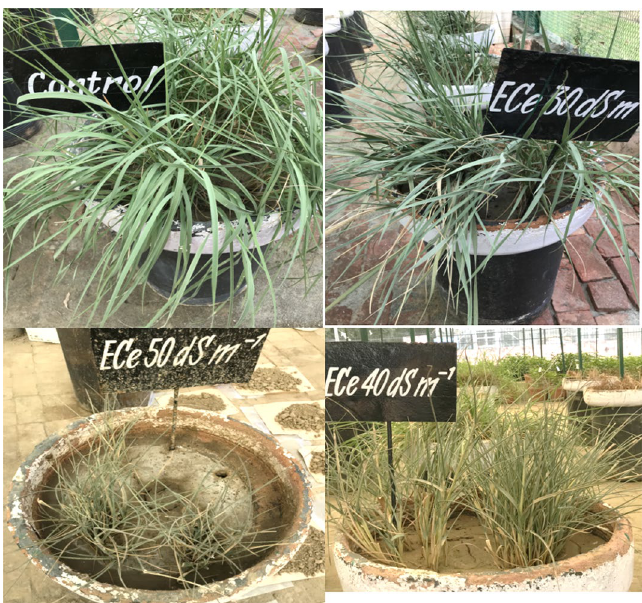
Figure 1. Urochondra setulosa plants at different treatment